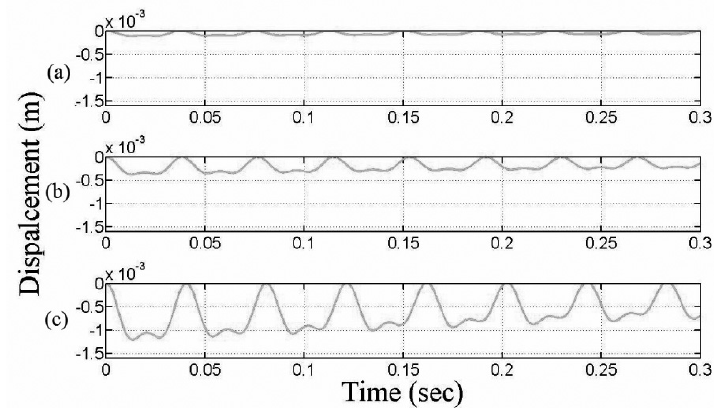
Fig. 6. Correction term for β = 0.9 and (a) α = 0.3, (b) α = 0.5, (c) α =